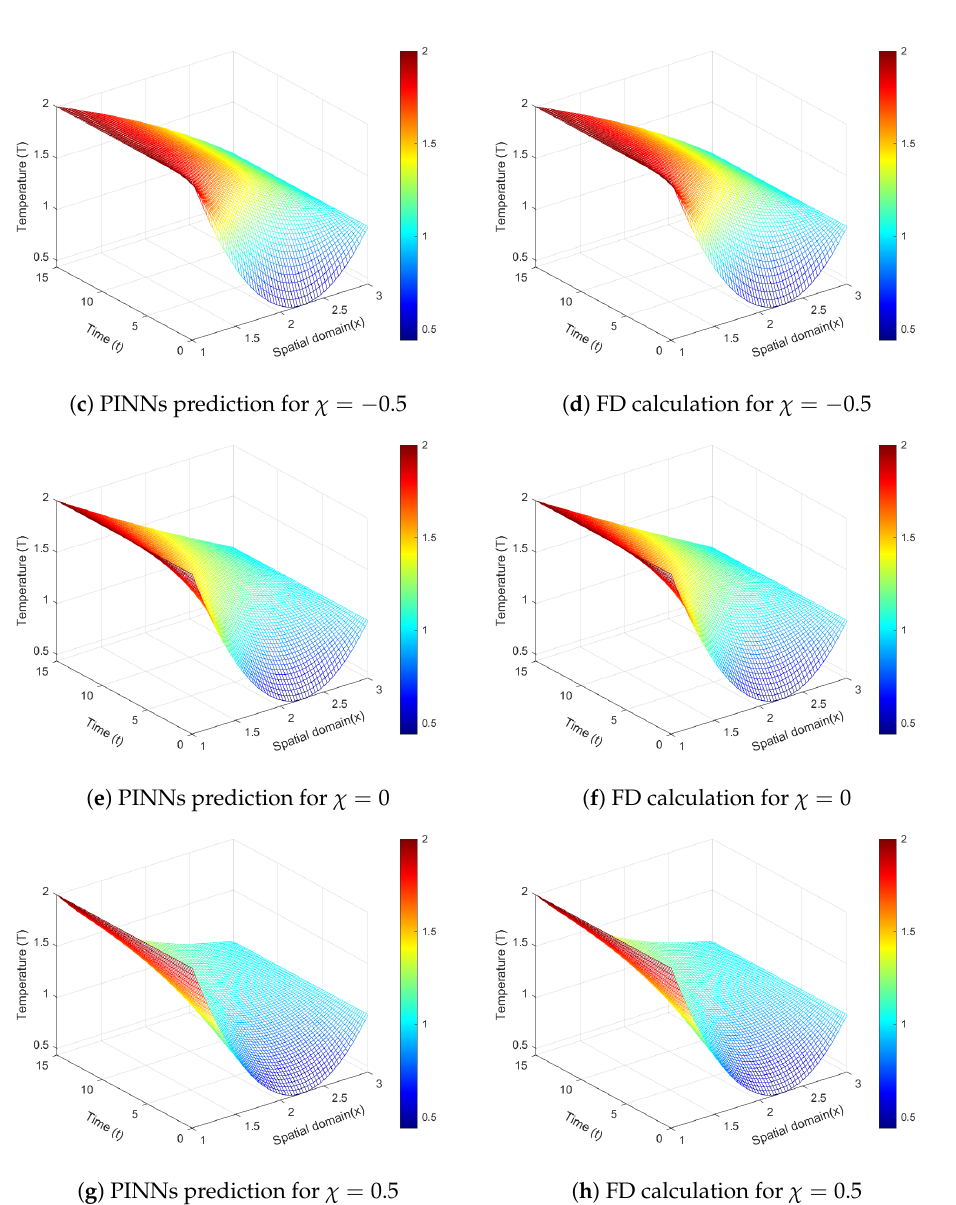
Figure 14. Comparisons between PINN prediction and numerical